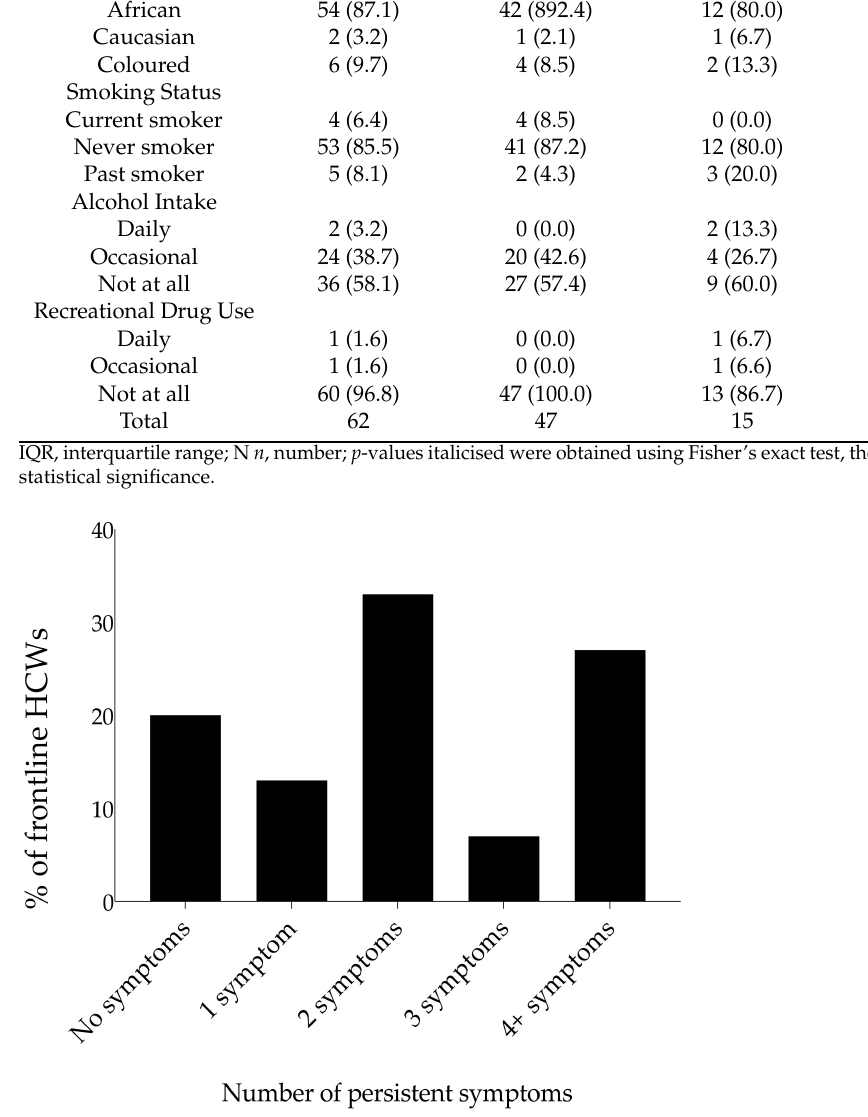
Figure 7. Persistent COVID-19 symptoms at three months and longer ( n = 15). Number of symptoms remaining after 3 months post-acute infection for frontline workers experiencing persistent symptoms. Bars show the percentage of respondents that reported none or at least one